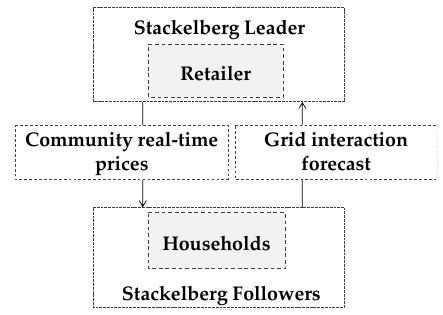
Figure 6. Two-level Stackelberg game structure in the C-RTP tariff.